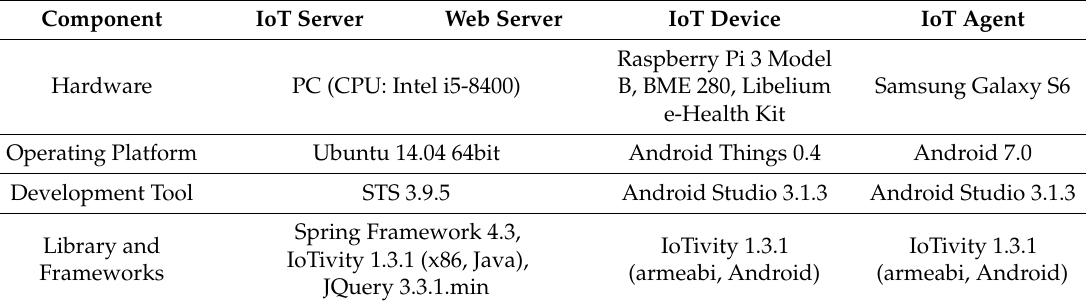
Table 1. Development environment of proposed entities.